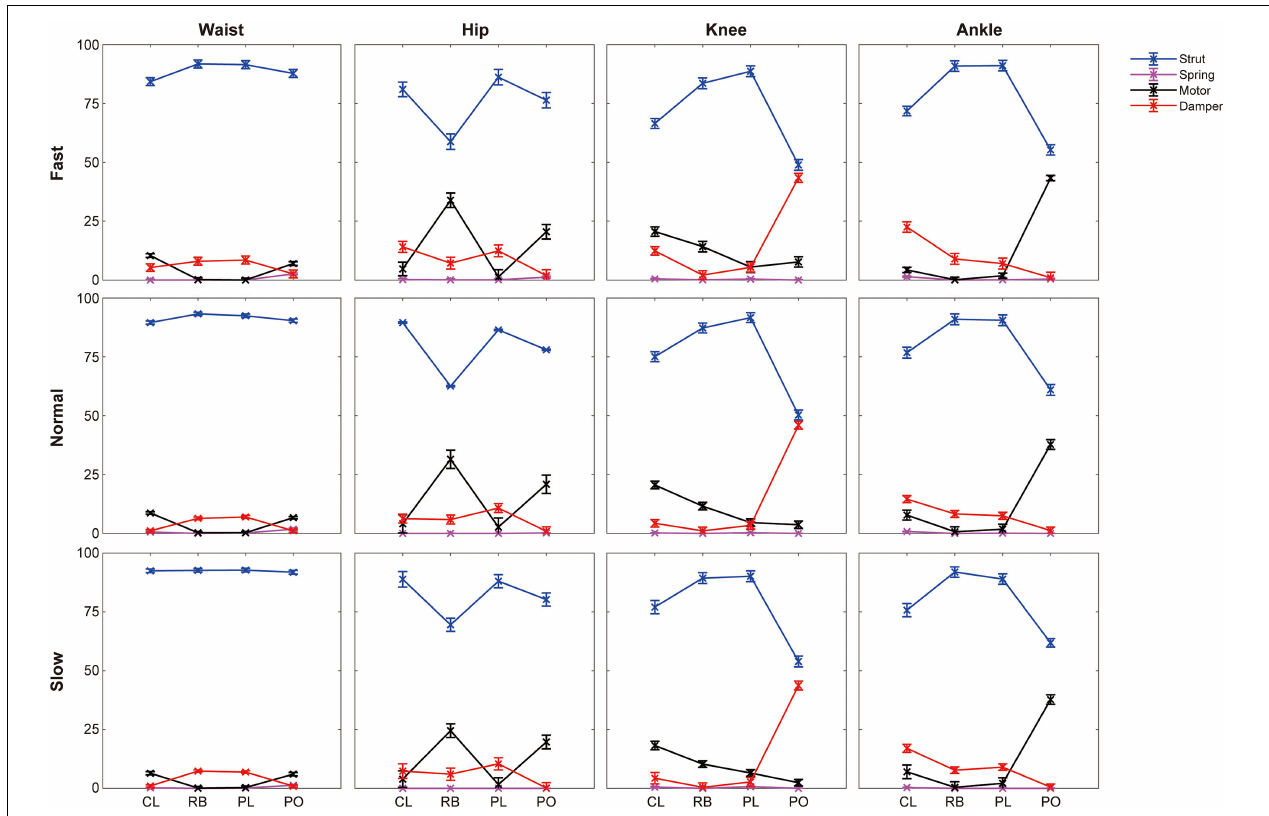
FIGURE 3 | Functional behaviors of joints during different phases across three walking speeds. N = 6; mean ± SD. were depicted. CL, collision; RB, rebound; PL, preload; PO,